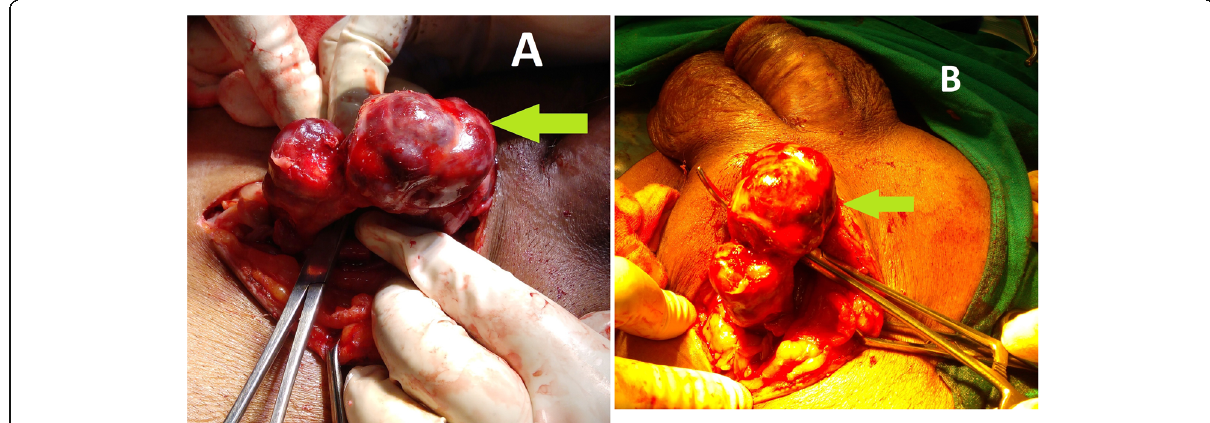
Fig. 1 a , b Intra-operative photographs. Green arrows show thrombosed left pampiniform